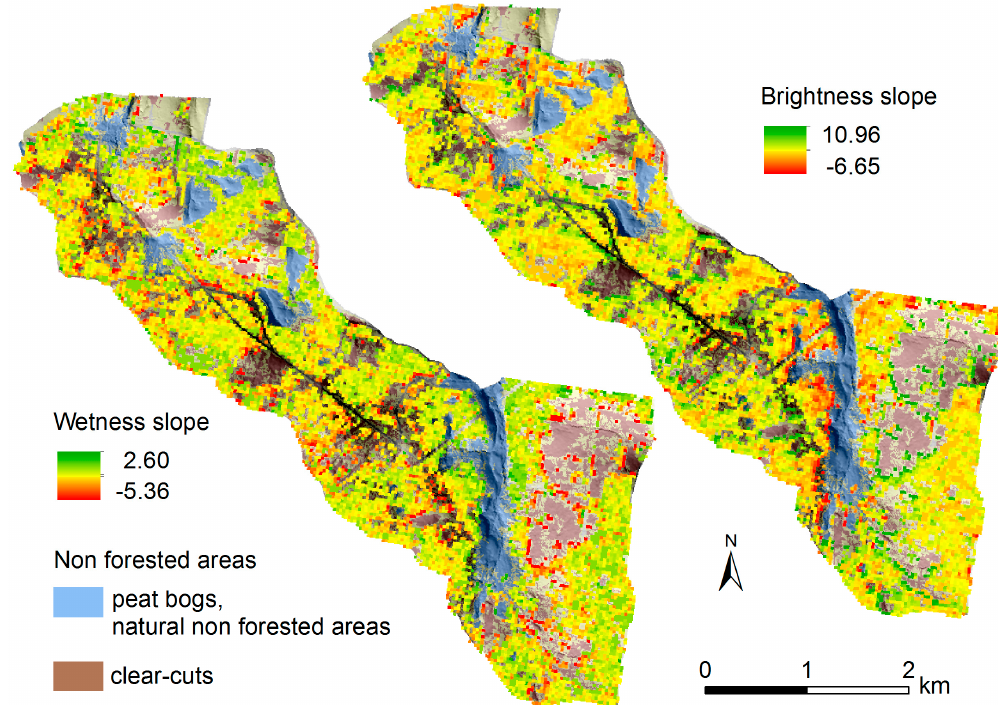
Figure 3. Spatial distribution of Wetness slope and Brightness slope values. Similar to Figure 2, the pixel values were calculated as the slope of linear regression of Wetness/Brightness for consecutive years from 1984 to one year before the year for which the model was calibrated. The maps are composed from pixels combined among all evaluated years (1994–2000) according to the year of bark beetle infestation. The lowest Wetness slope values and highest Brightness slope values are mostly adjacent to clear-cuts, while the slope values in the vicinity of natural non-forested areas show opposite behavior, especially in the Lusen valley.